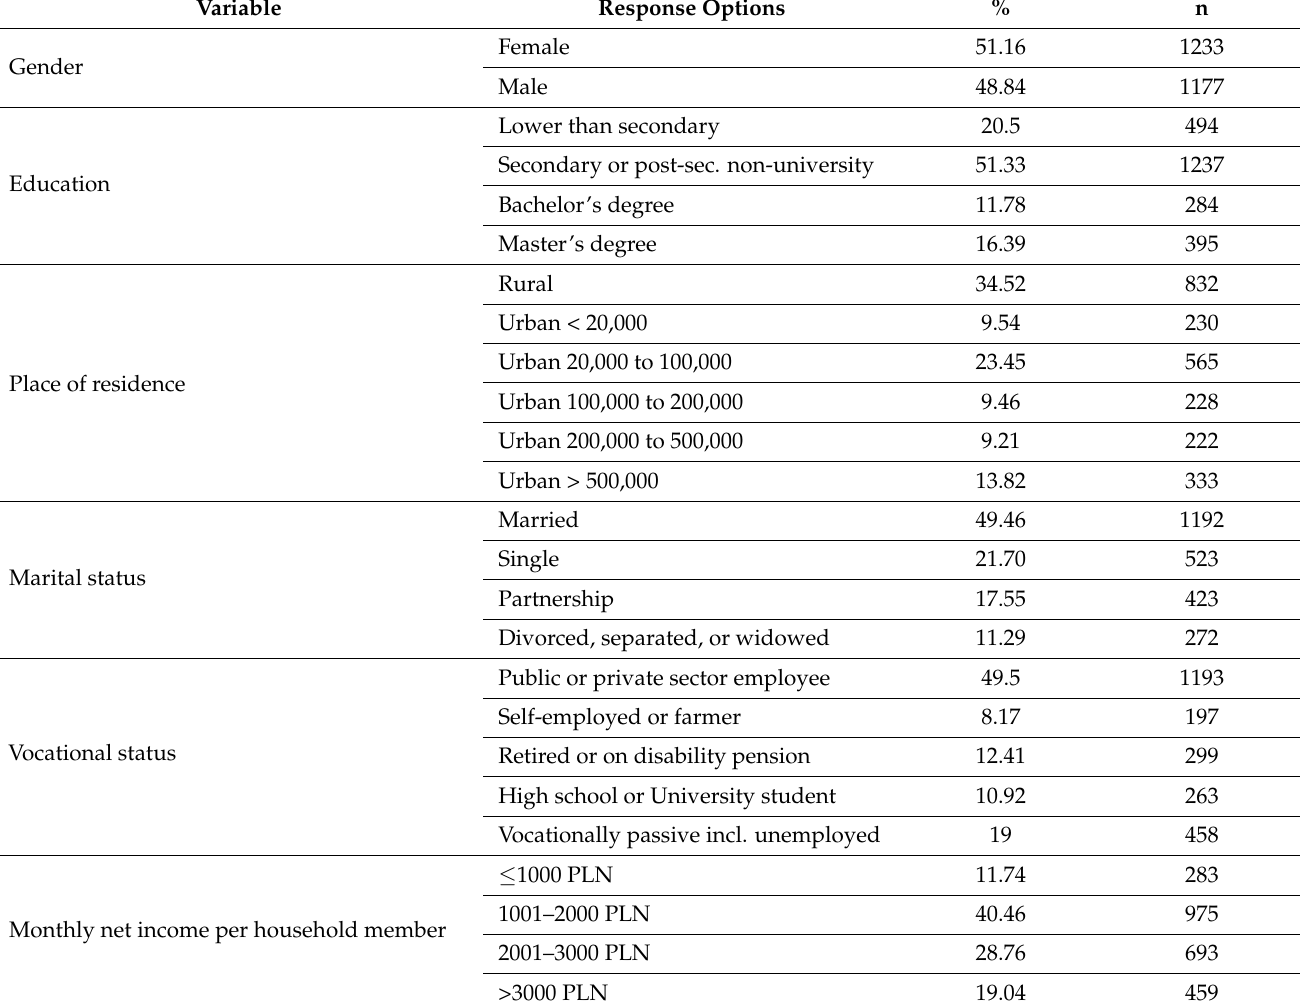
Table 1. Characteristics of the study